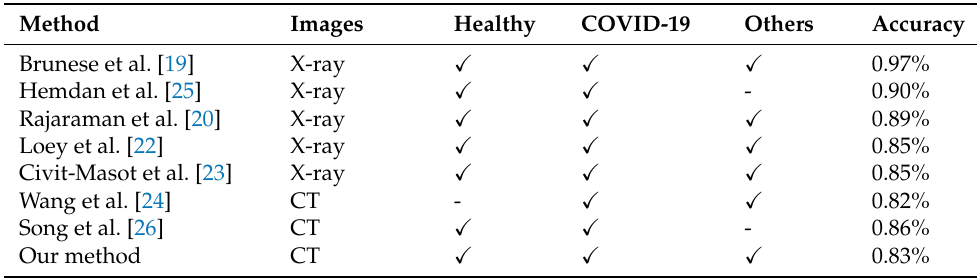
Table 6. State-of-the-art